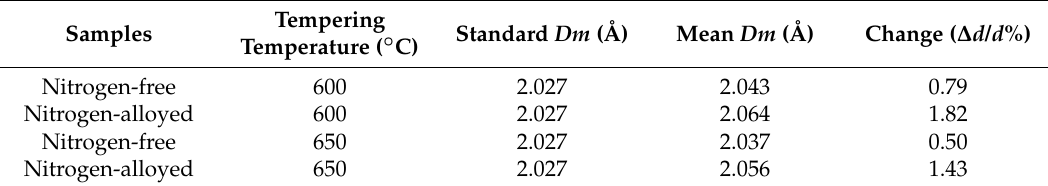
Figure 6. X-ray diffraction result showing the lattice distortion of tested steels quenched at 1030 °C and tempered at 600 °C and 650 °C for 4 h. Table 3. Lattice distortion of samples quenched at 1030 °C for 0.5 h and tempered at 600 °C and 650 °C, respectively, for 4.0 h. ( Dm : Interplanar distance.)